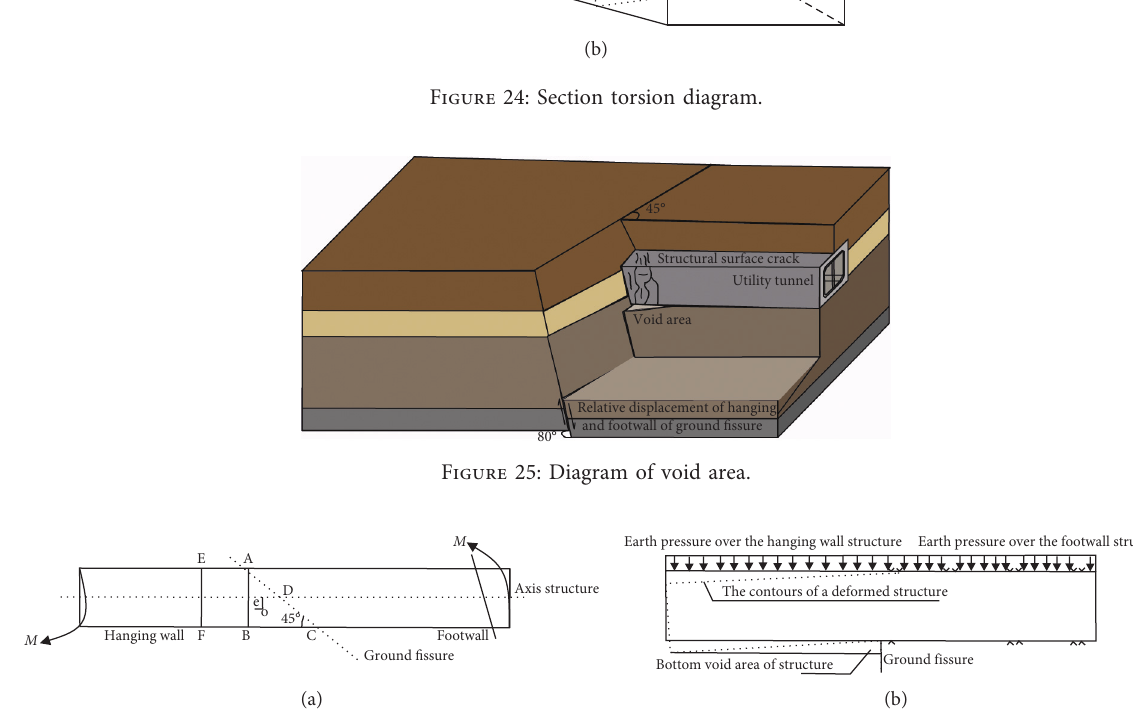
Figure 26: Structural force. (a) Force on the top of the structure. (b) Side force of the structure.